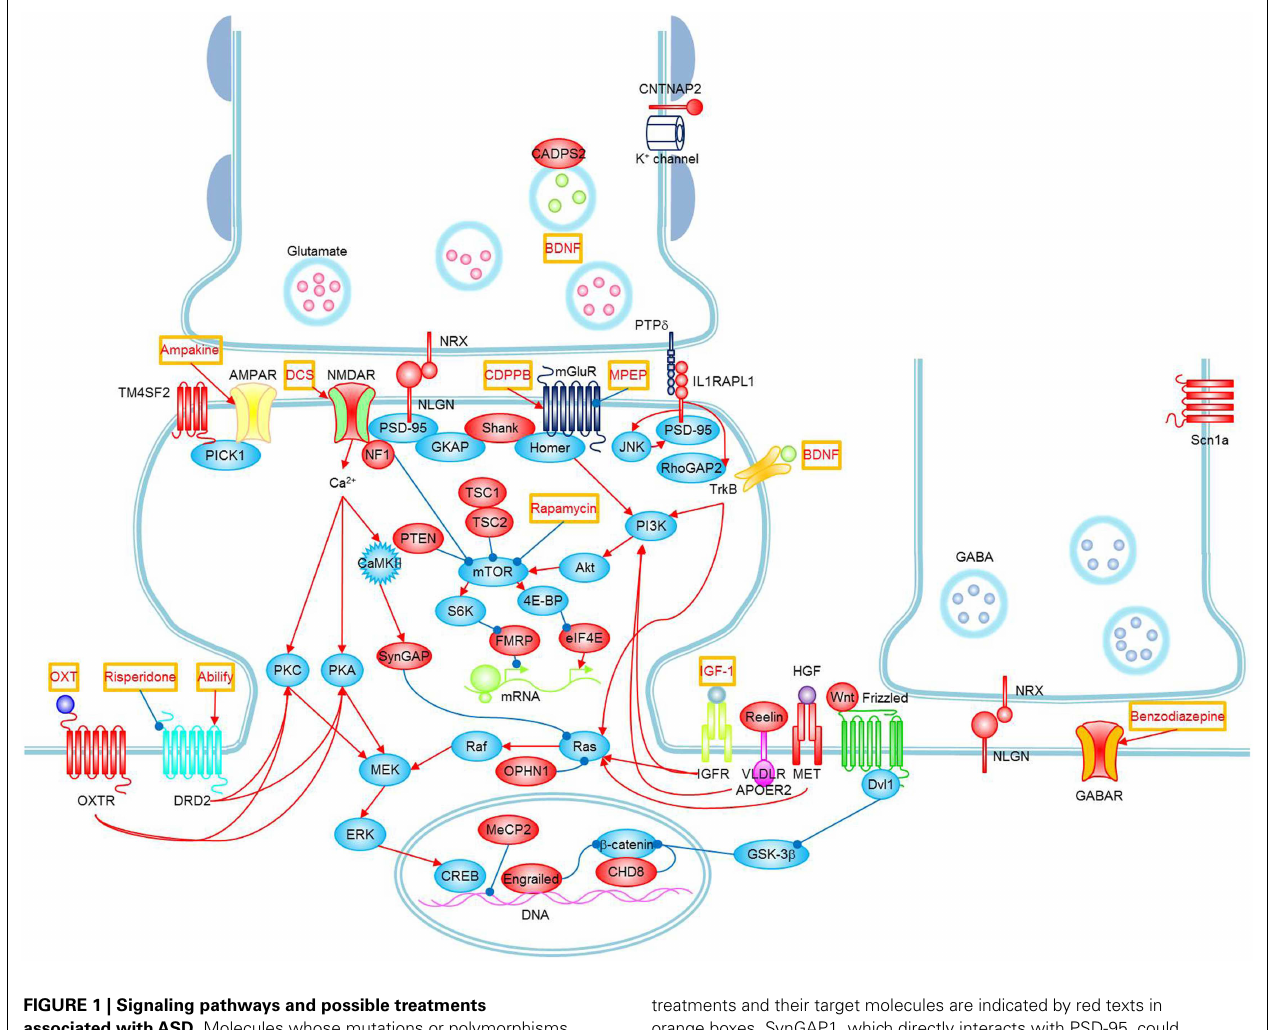
FIGURE 1 | Signaling pathways and possible treatments associated withASD . Molecules whose mutations or polymorphisms are associated with ASD are indicated in red. Stimulations and inhibitions are indicated by red and blue arrows, respectively. Possible